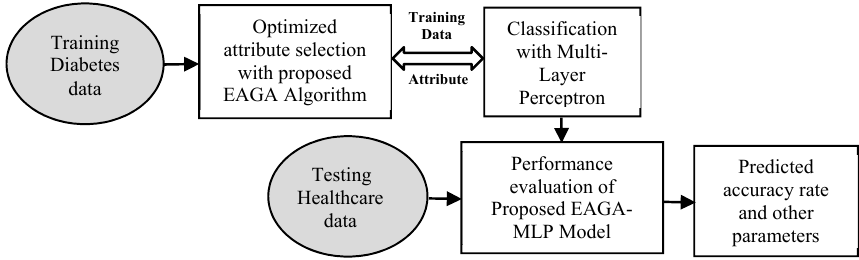
Figure 2. Proposed Optimized Attribute Selection Method. 493 Figure 3. Classification Model based on our Proposed Attribute Selection method (Enhanced and Adaptive-Genetic Algorithm-Multilayer Perceptron